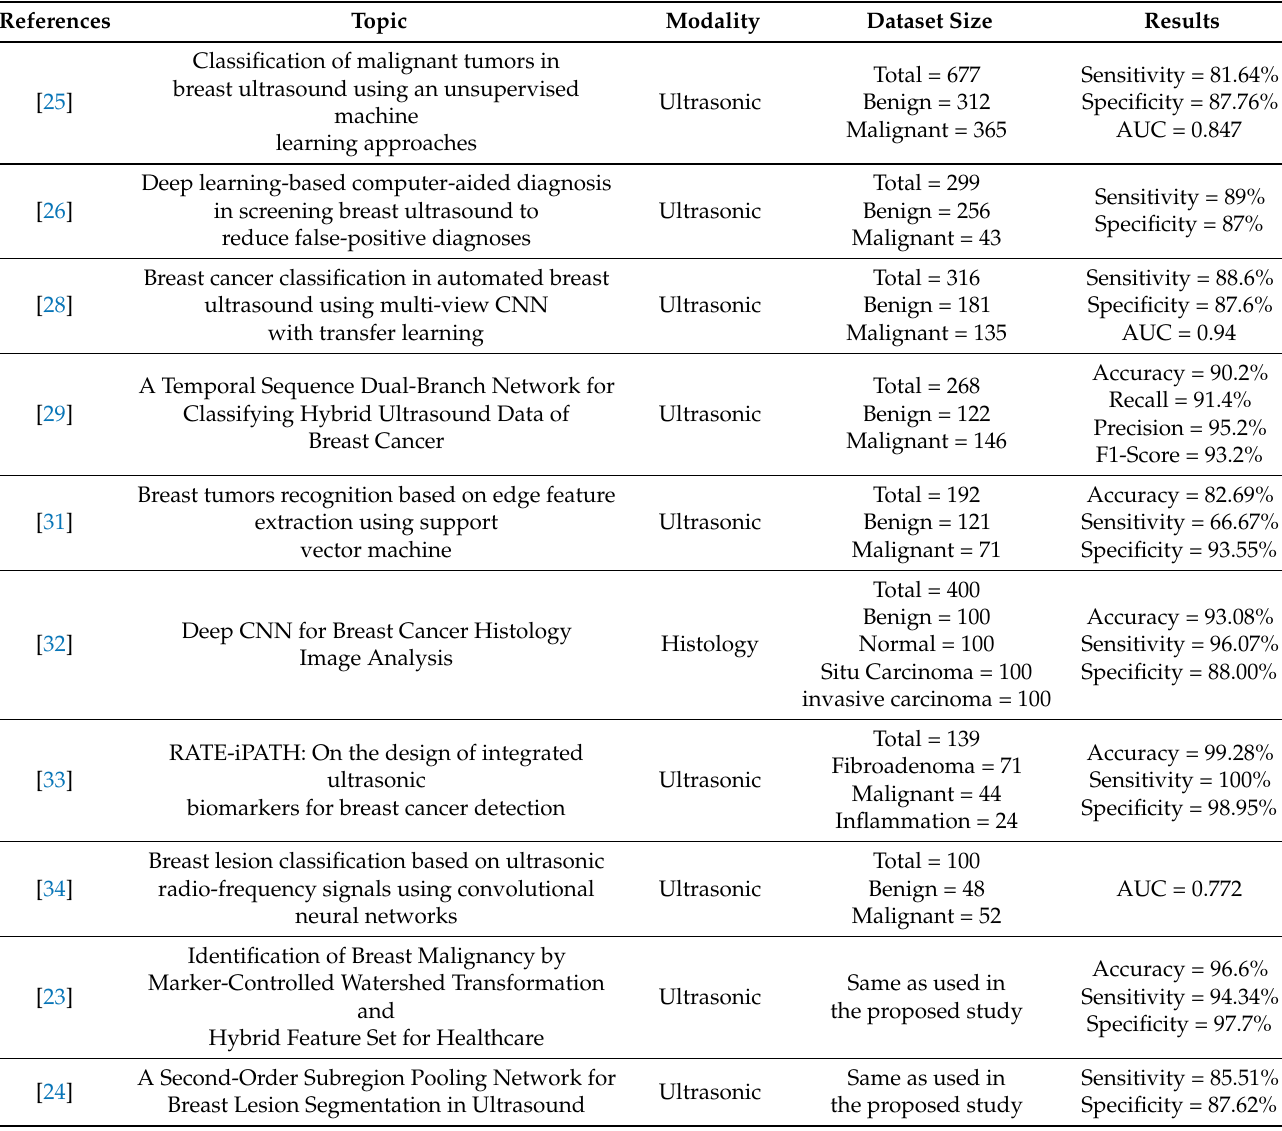
Table 1. Detailed summary of related works with their modalities and